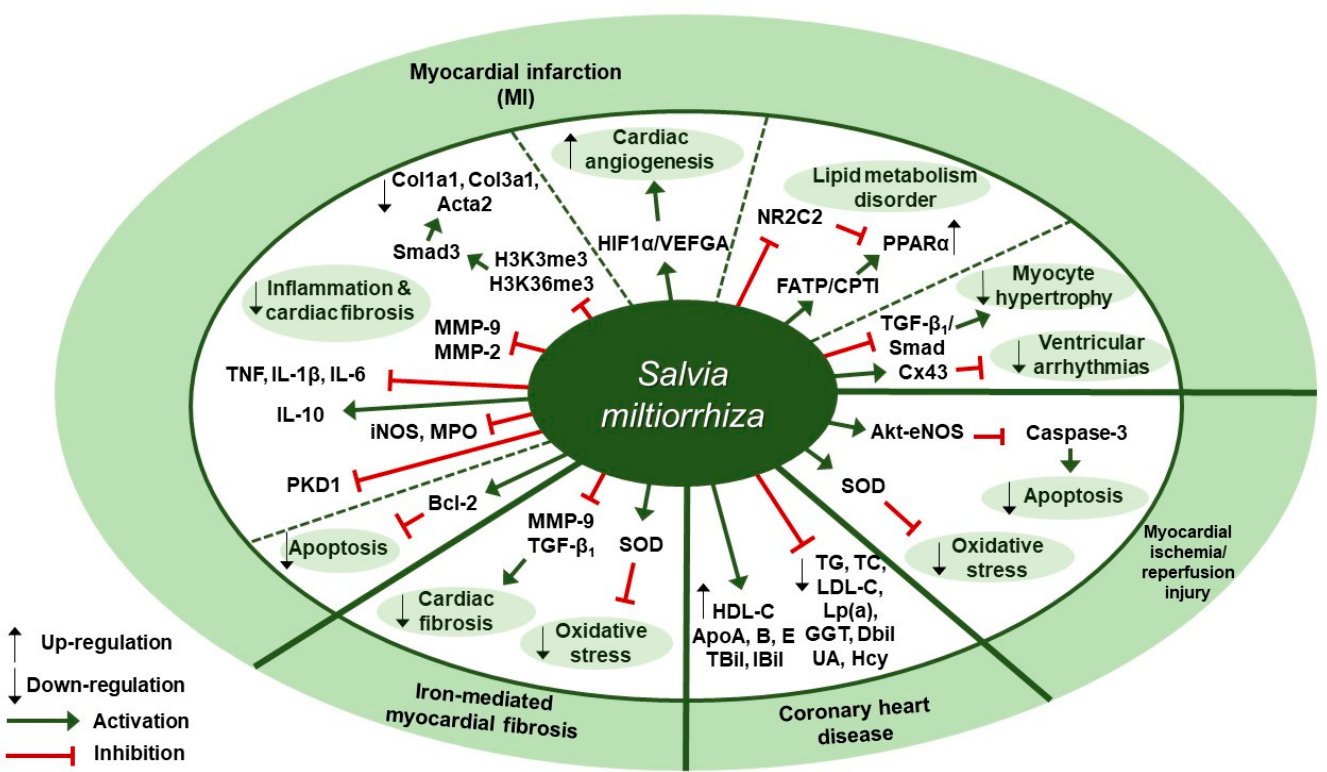
Figure 2. Therapeutic targets of S. miltiorrhiza in cardiovascular diseases. HIF1 α , hypoxia-inducible factor 1 α ; VEGFA, vascular endothelial growth factor A; NR2C2, nuclear receptor subfamily 2 group C member 2; FATP, fatty acids transport protein; CPTI, carnitine palmitoyltransferase I; PPAR α , peroxisome proliferator-